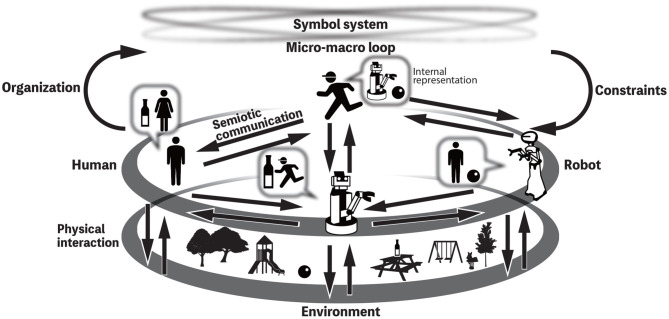
Overview of the symbol emergence systems (Taniguchi T. et al., 2016).